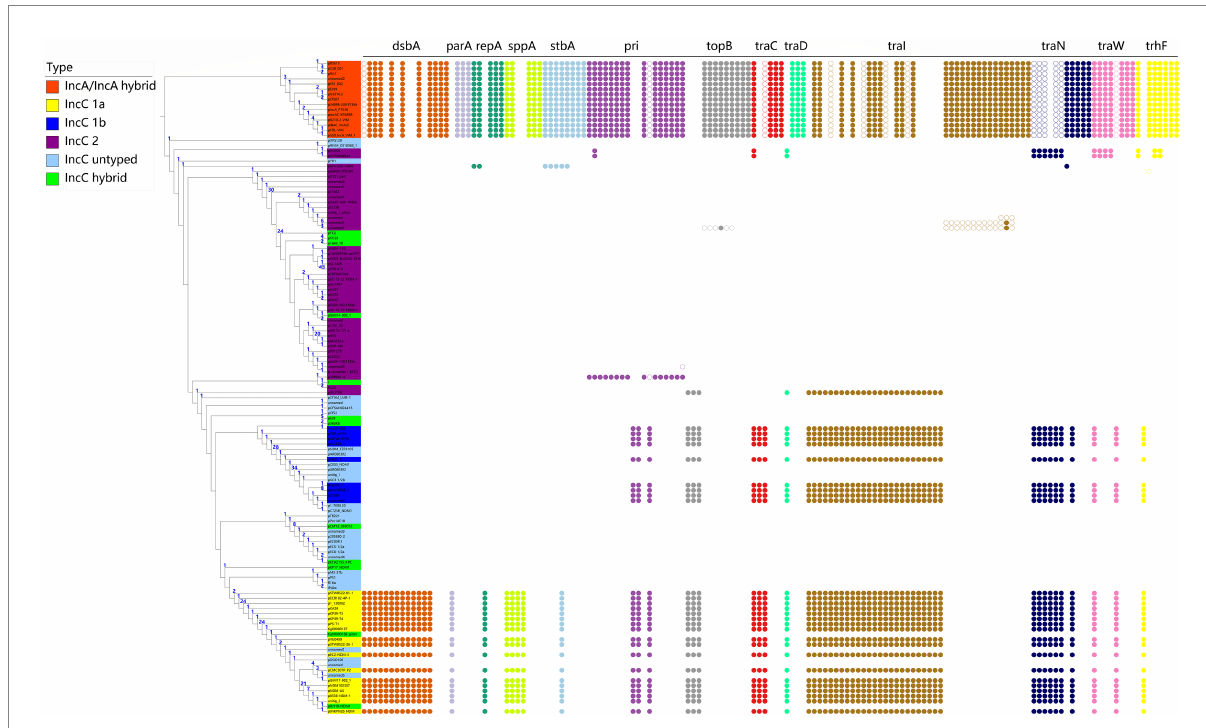
FIGURE 3 Phylogenetic relationship of representative plasmids of IncA and IncC plasmids and corresponding amino acid divergence. The evolutionary history was inferred using concatenated core functional genes. The difference in amino acids compared with the reference plasmid pR55 is shown by coloured circles that represent different amino